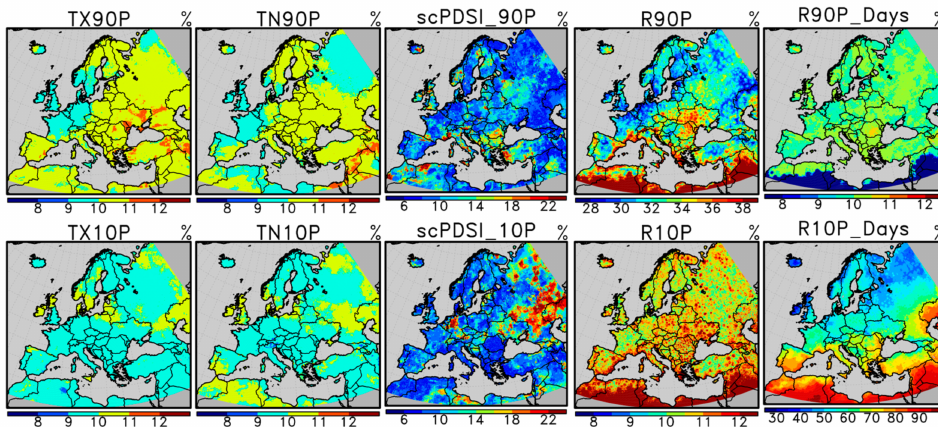
Figure 3. The climatological means (1979–2016) of the extreme